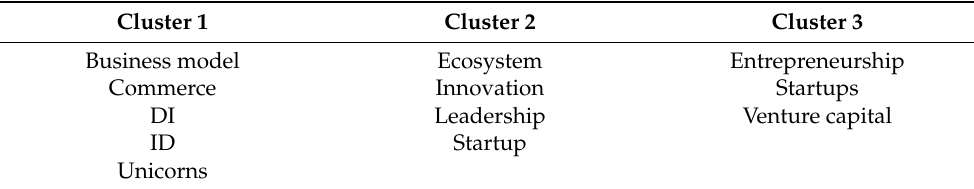
Table 15. Clusters related to the unicorn as a keyword (SCOPUS